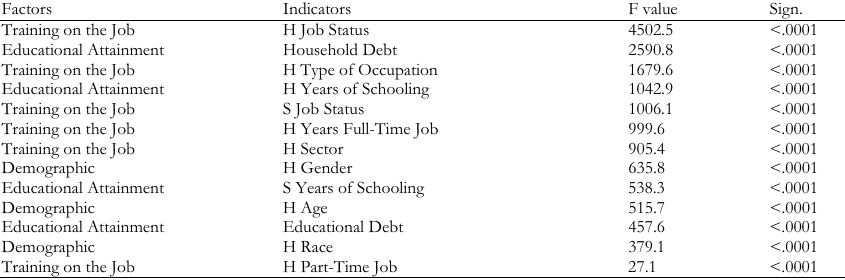
Formative Indicators (and statistical significance) of the HC estimation for US Families